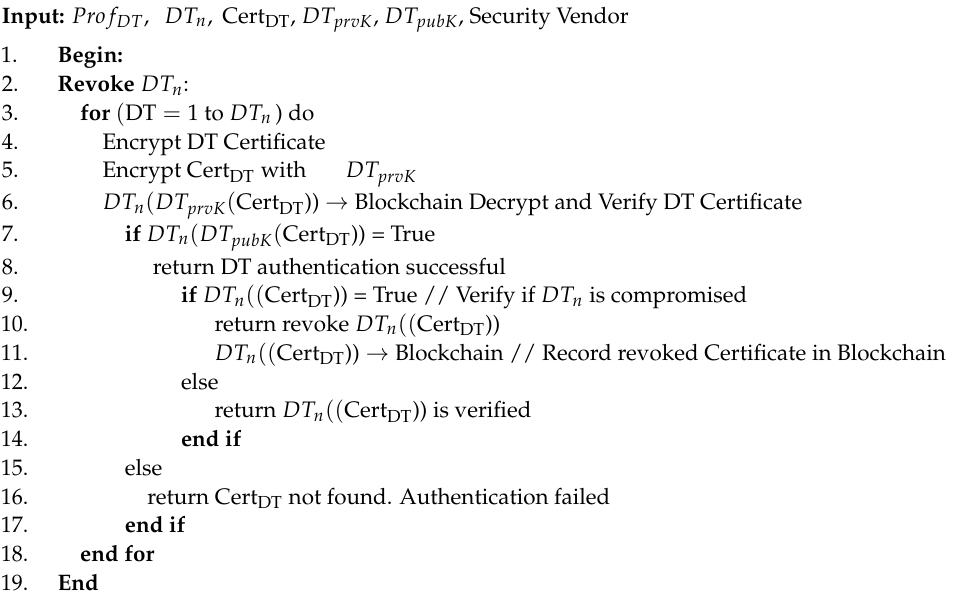
Algorithm 3 Device